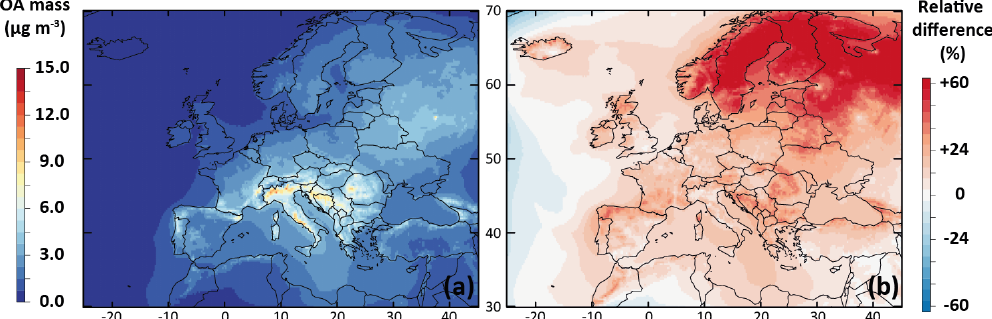
Figure 2. Mean OA mass concentrations simulated with the ref-VBS-GECKO model configuration over Europe for the July–August 2013 period (a) and relative difference of the simulated mean OA mass concentrations between the ref-VBS-GECKO and the H 2 O configura- tion (b) . Table 3. Statistical results calculated on daily averaged concentrations for the ref-VBS-GECKO simulations and differences between ref- VBS-GECKO and H 2 O statistical indicators. Observations VBS-GECKO results Differences with H 2 O